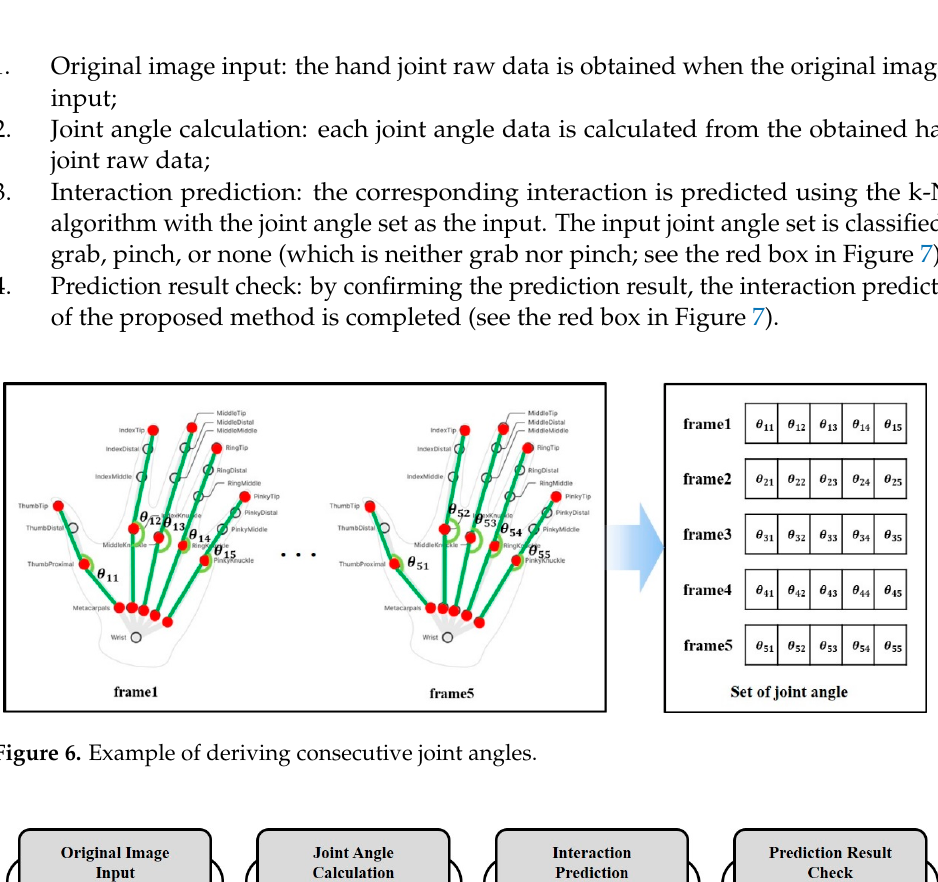
Figure 6. Example of deriving consecutive joint angles.